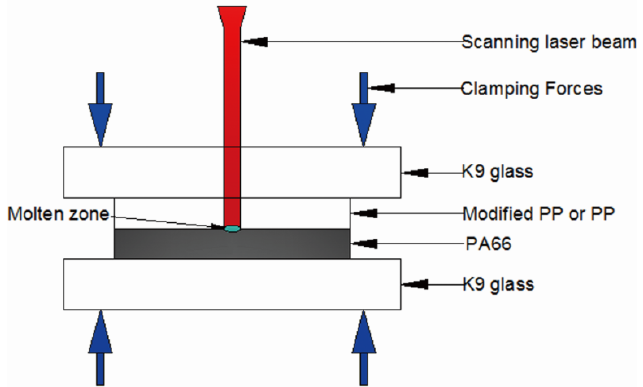
Figure 10. The diagram of laser transmission welding between PP TGMPP and PA66.